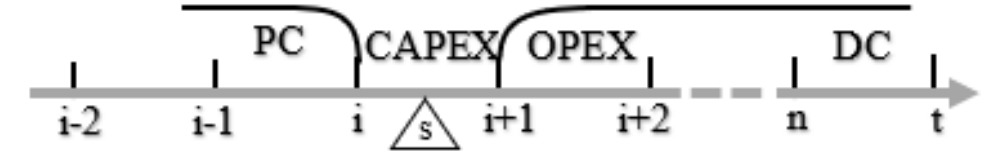
Figure 5. Distribution of the cost